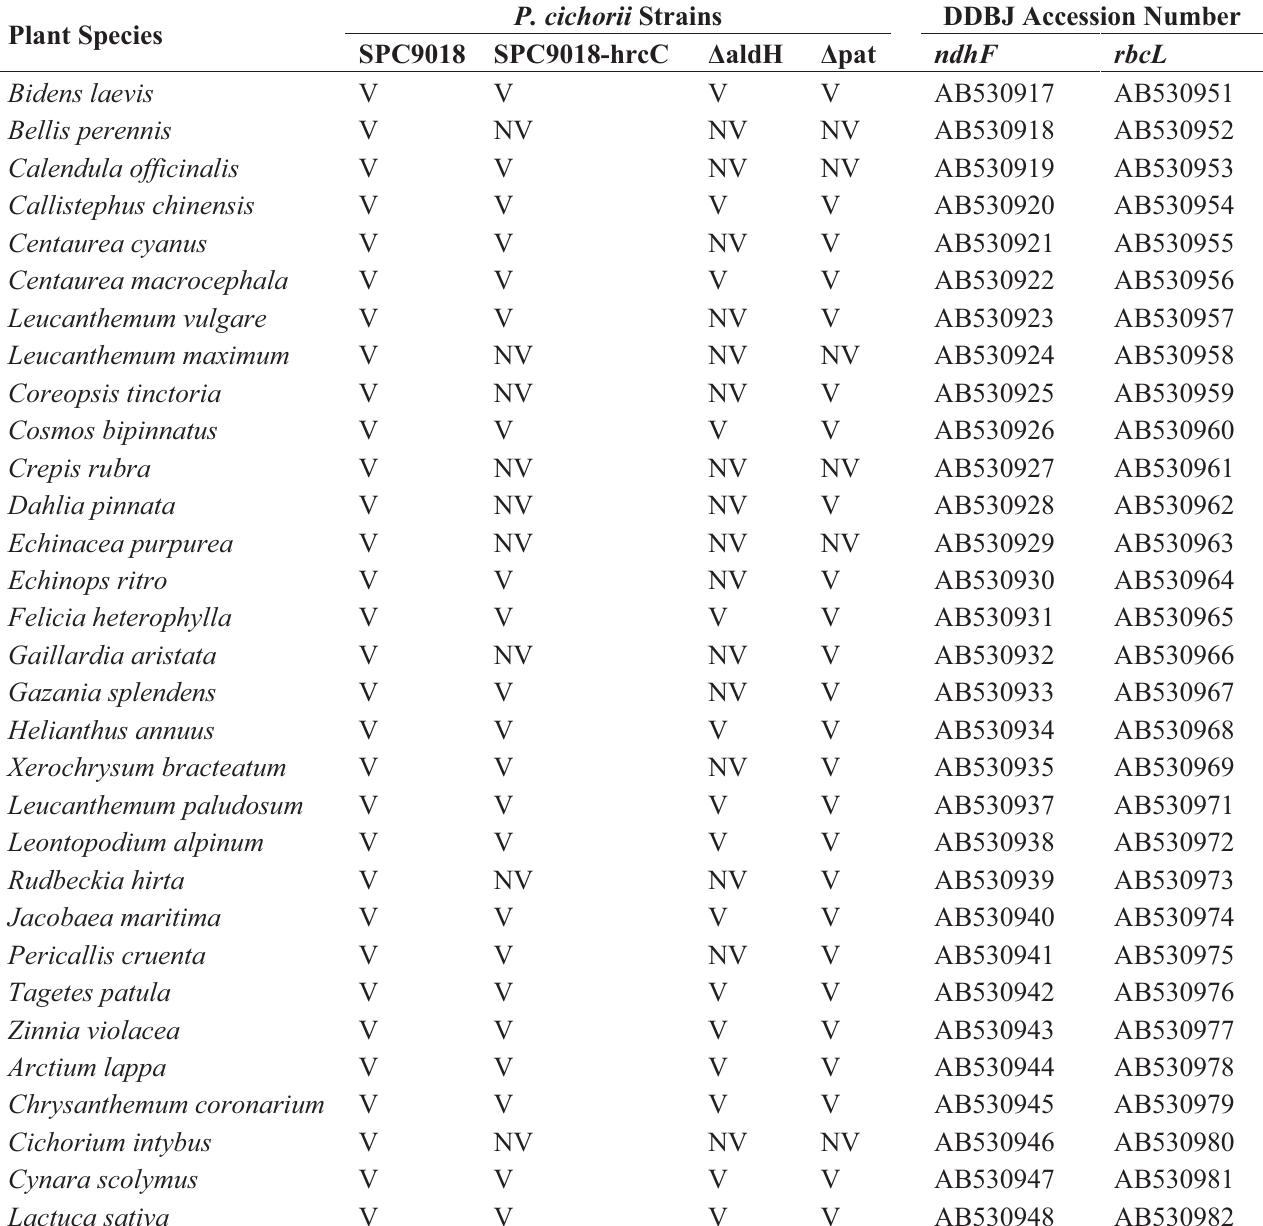
Table S2. Virulence of P. cichorii strains on the Asteraceae plants and the accession numbers of the nucleotide sequences of ndfH and rbcL deposited in the DDBJ/GenBank international nucleotide sequence database.